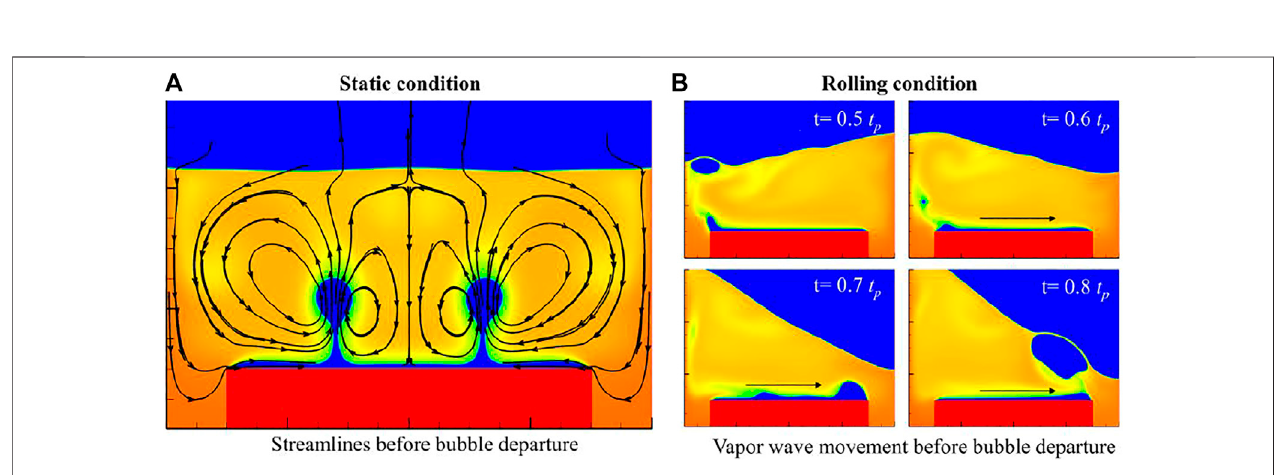
FIGURE 11 | Analysis of bubble departure at fi lm boiling under static and rolling conditions.